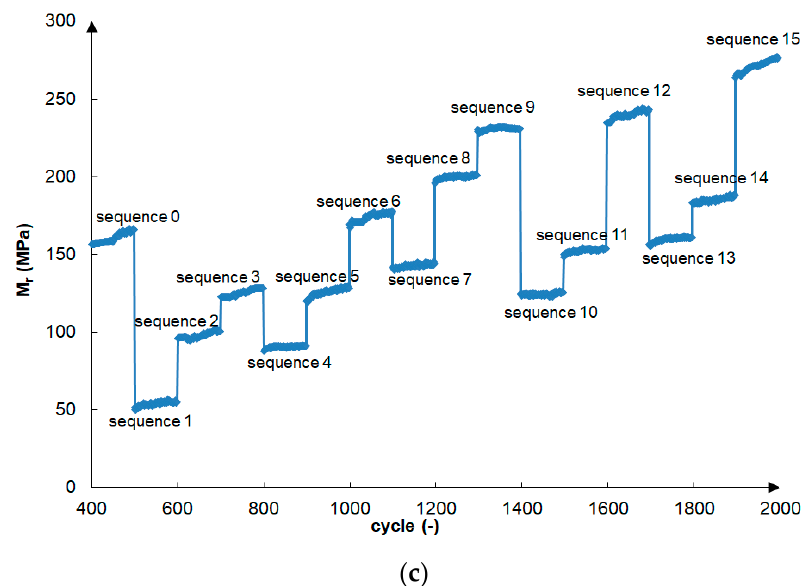
Figure 6. Variations in resilient modulus for the following samples: ( a ) grSa compacted via the SP method damaged in sequence “1”, ( b ) grSa + 0.2%F 18 mm compacted via the SP method damaged in sequence “2”, ( c ) grSa + 1.5%C + 0.2%F 18 mm compacted via the SP method and cured for 7 days tested in all test cycles (see Table 2).